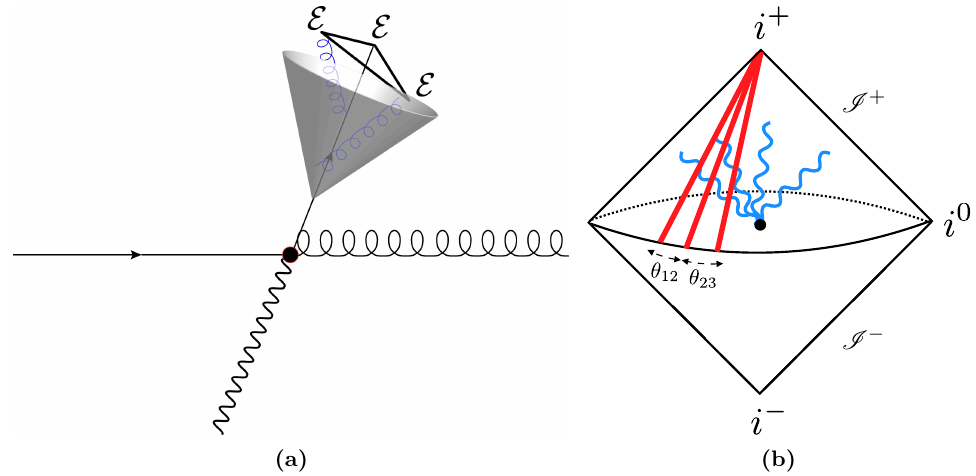
Figure 1. (a) Energy correlators measured inside an identified jet at the LHC. (b) A Penrose diagram of the spacetime structure of three light-ray operators measured on a state produced by a local operator. Due to the universality of the OPE limit, symmetry techniques applicable to (b) can be used to understand